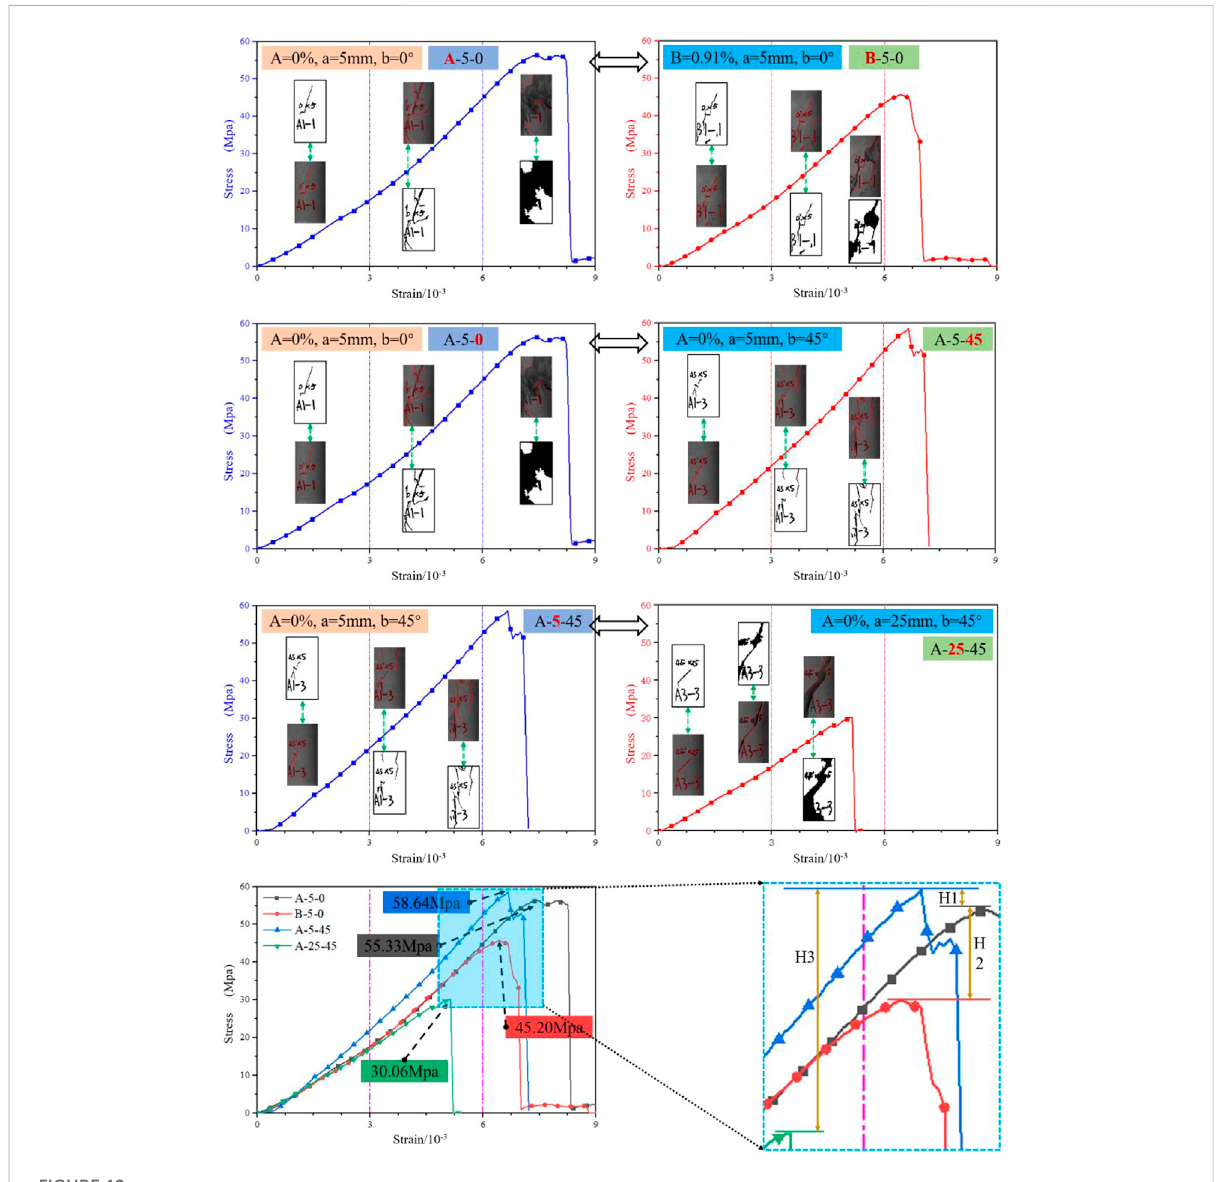
FIGURE 12 Variability factor analysis